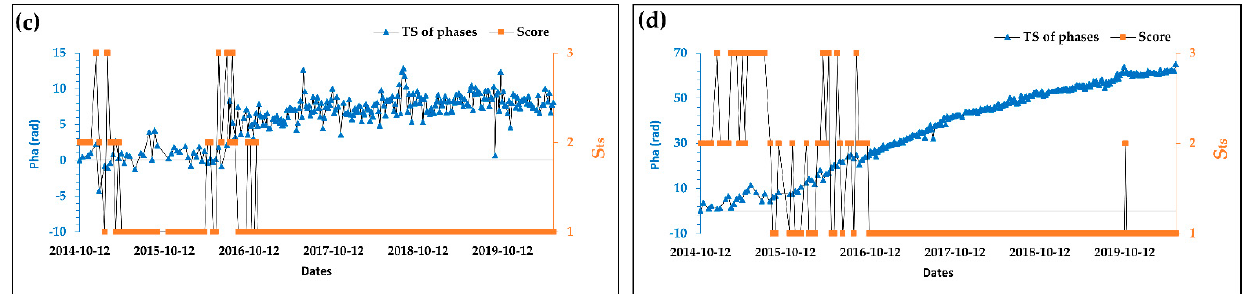
Figure 7. TS measurements and the corresponding scores are indicated in blue and in orange colors,